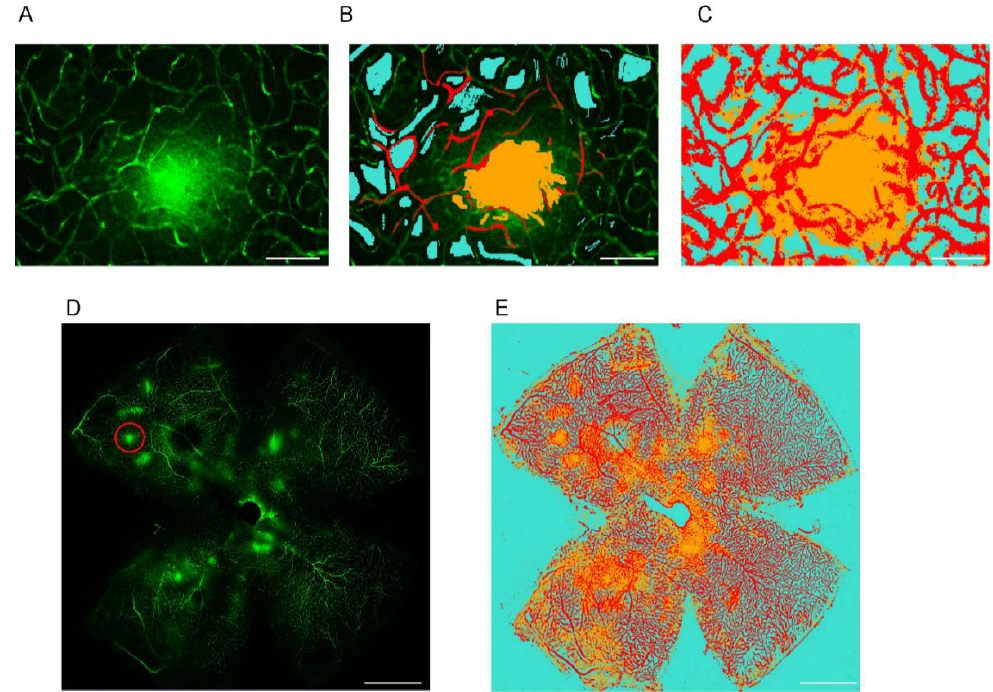
Figure 1. Representative images of whole mounted retina after labeling with machine learning. ( A ) Magnification of the area within the red circle in ( D ). ( B ) Labeling of each segment. ( C ) After analyzing the image. Scale bar is 100 µm. ( D ) Original image of retina using confocal microscope. ( E ) Image of retina after labeling. The yellow shows leakage, the red shows vessels and artifacts, and the cyan shows background. Scale bar is 1mm.